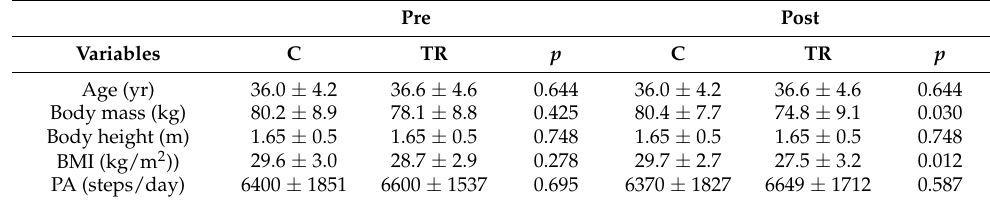
Table 1. Participants’